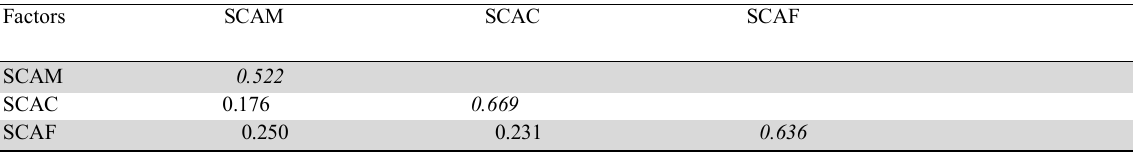
Discriminant validity analysis for